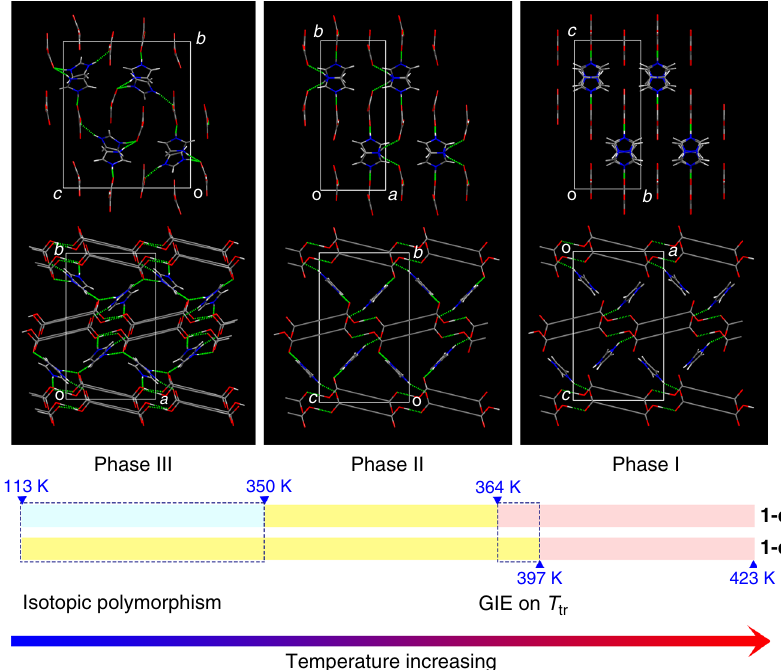
Fig. 4 Structures of the different phases. Variation in the H-bonding networks in the three phases (phase I, light pink; phase II, yellow; phase III, light cyan), shown in a front view (upper row) and cross-sectional view (lower row) to the host channel. 1-d 0 and 1-d 5 are selected to represent the H and D isomorphs, respectively. The benzene ring in TPA is schematically drawn as a long C – C single bond for clarity. Red: O; blue: N; gray: C; light gray: H/D. The H bonds are represented as dotted lines. Isotopic polymorphism occurs below 350 K (phase III). The difference in the I – II phase transitions between 1-d 0 and 1-d 5 reveals the H/D isotope effect on T tr (a downward shift of approximately 33 K). Note: the temperature ranges are schematically